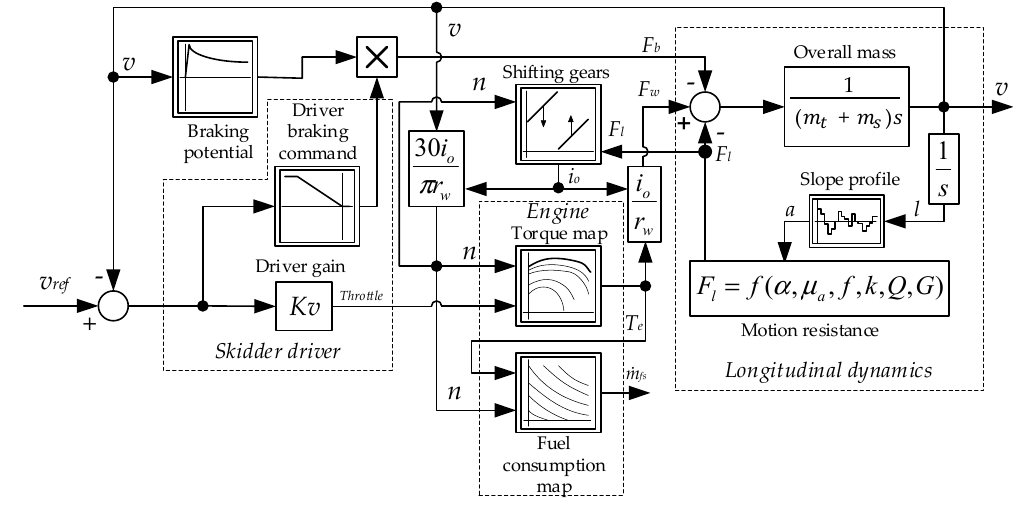
Figure 3. Block diagram of a conventional skidder power-train and driveline control strategy.